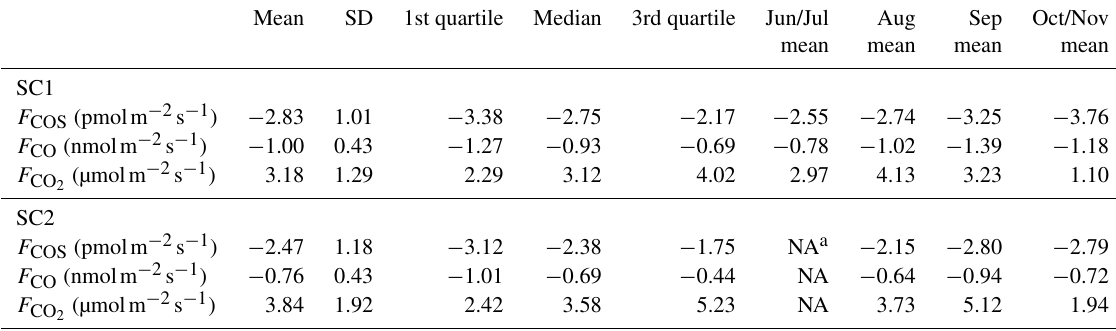
Table 1. A statistical summary of fluxes from the two soil chambers.